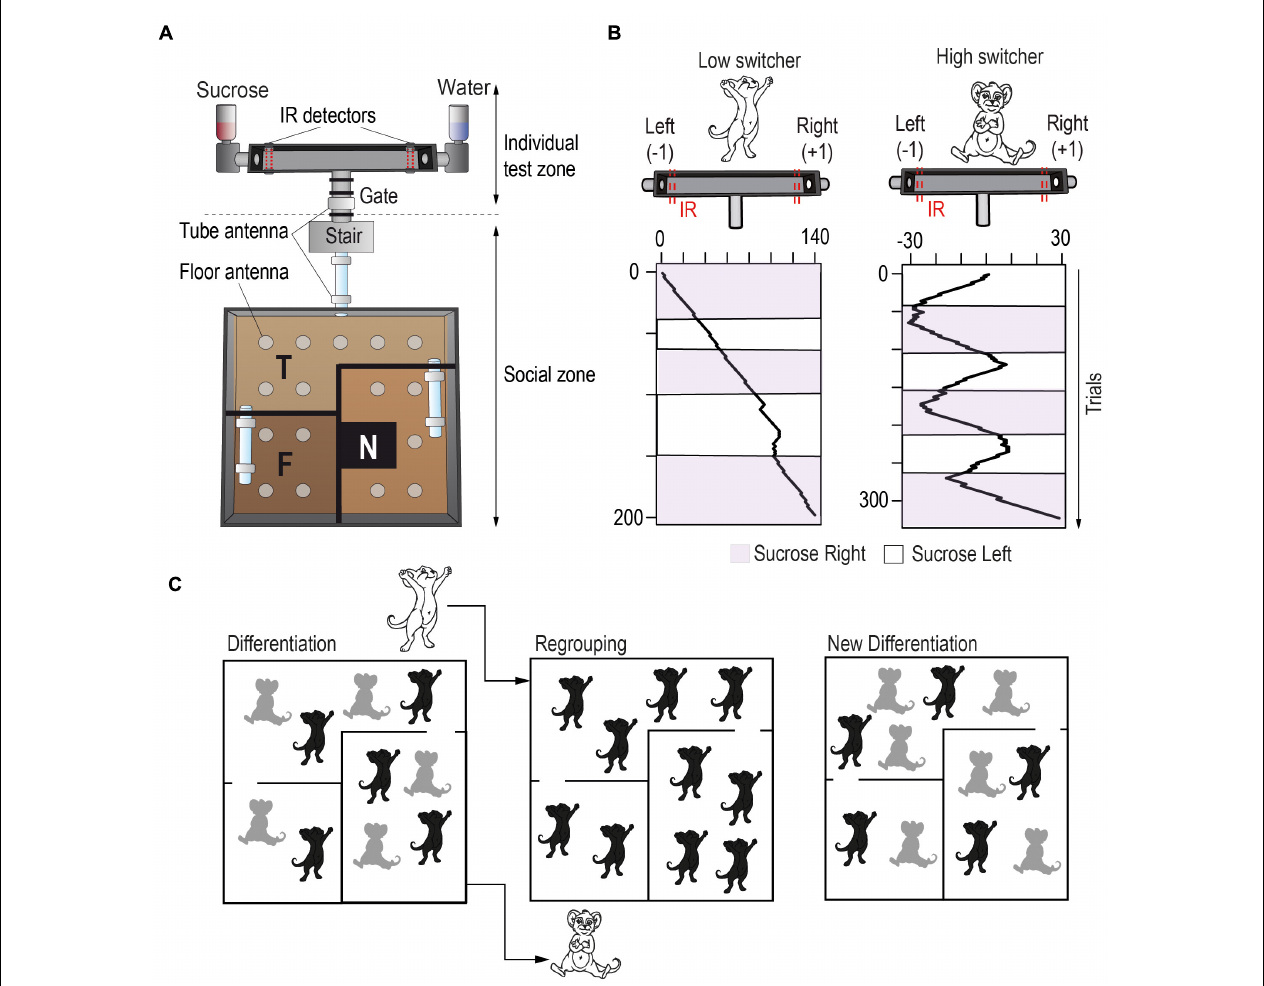
FIGURE 2 | Semi-naturalistic environments allow the study of inter-individual variability with a social context. (A) Souris-City environment includes a large and complex living space, in which mice live together and can express sophisticated social and non-social behaviors, and an individual test zone: a T-maze delivering different drinks on each side (e.g., water or sucrose). In the T-maze, mice (inbred male C57BL/6J strain) can perform a cognitive decision-making task spontaneously and isolated from their conspecifics. The various detectors present in the environment allow to follow each individual’s behavior and estimate spontaneous individual traits. These are derived from both the general behavior expressed within the social group in the main environment, and the behavior and cognitive performance in the individual test zone. (B) Stable and distinctive patterns of choice strategy in the T-maze consistently emerged in independent experiments with, in particular, individuals tracking sucrose (right panel) and individuals constantly choosing the same side independently from the sucrose position (left panel). (C) Strikingly, when modifying the social environment by mixing mice from different Souris-City experiments but with similar behaviors, we observed a fast re-adaptation of individual traits, suggesting a social component to this individuation process (Torquet et al.,